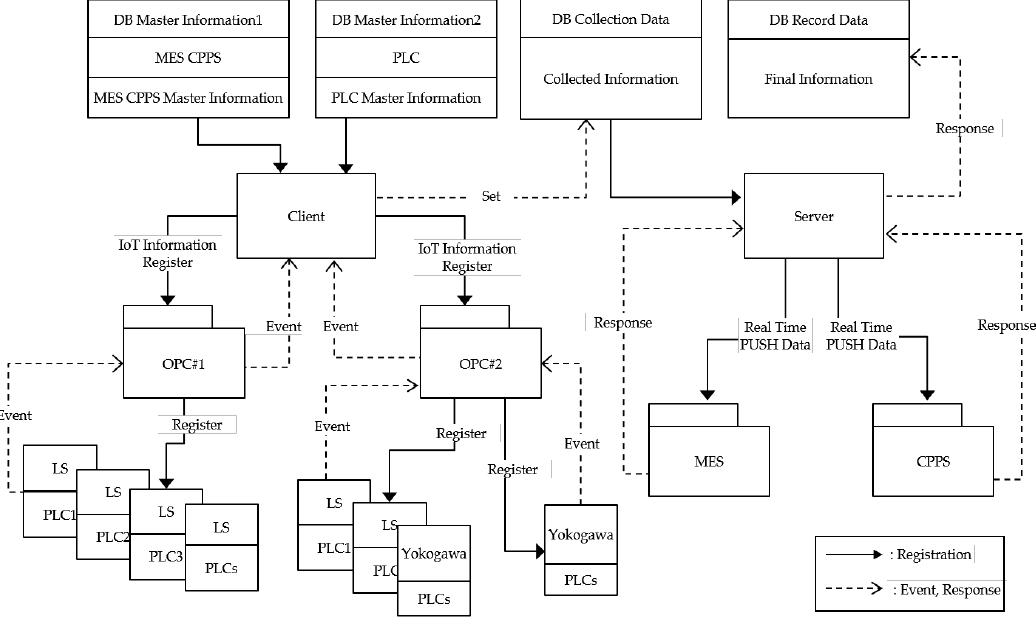
Figure 4. Interface of collecting data.